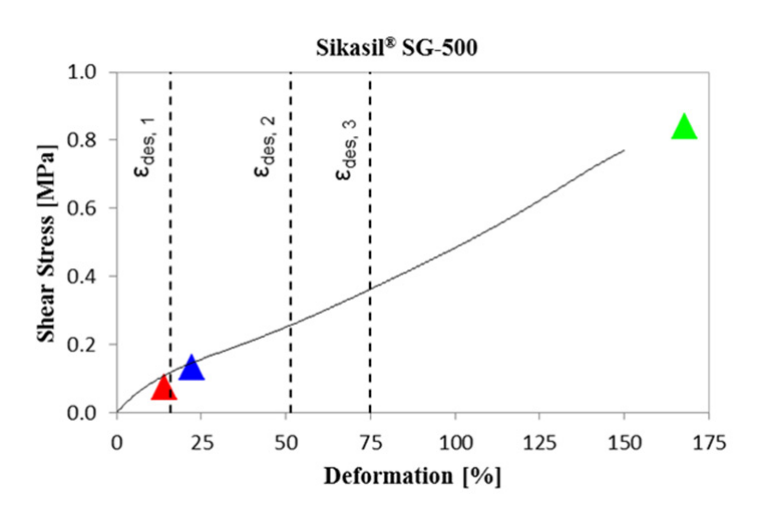
Fig. 13 Seismic mock up results: shear stress level in the SSG joints depending on performance